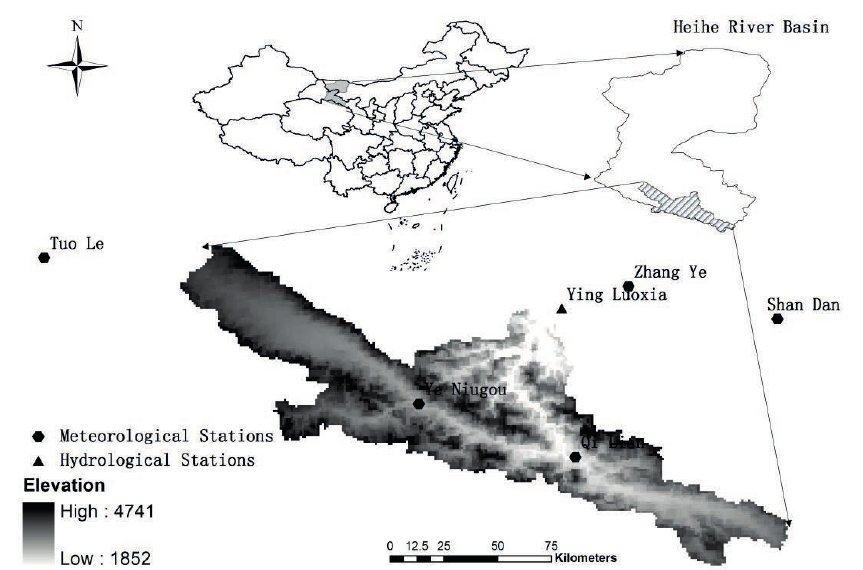
Fig. 1 Map of gauge and meteorological stations and the location of Heihe River